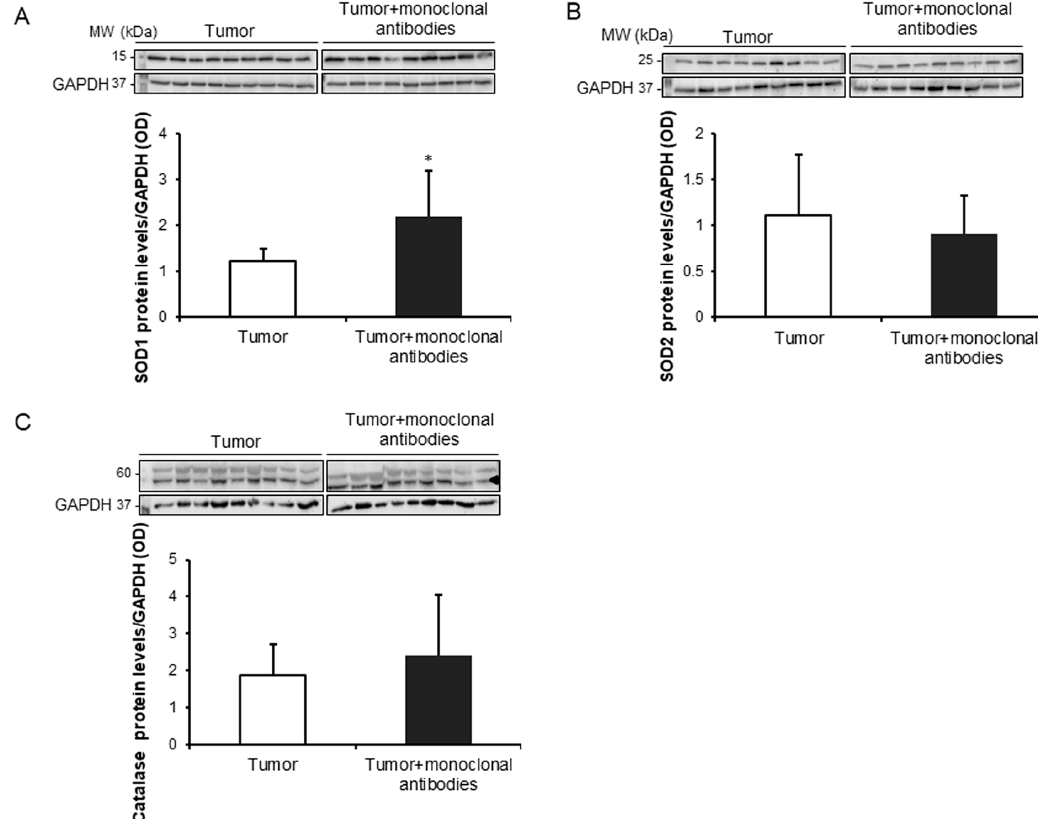
Figure 5. ( A ) Representative immunoblots and mean values and standard deviation of SOD1 protein levels / GAPDH in subcutaneous tumors of lung cancer mice as measured by optical densities. ( B ) Representative immunoblots and mean values and standard deviation of SOD2 protein levels / GAPDH in subcutaneous tumors of lung cancer (LC) mice as measured by optical densities. ( C ) Mean values and standard deviation of catalase protein levels / GAPDH in subcutaneous tumors of lung cancer mice as measured by optical densities. Representative GAPDH is shown as the loading control. Statistical significance is represented as follows: *: p ≤ 0.05 between non-treated controls ( N = 9) in white bars and treated lung cancer ( N = 9) mice in black bars. Definition of abbreviations: SOD1, CuZn-superoxide dismutase; SOD2, Mn-superoxide dismutase; GAPDH, glyceraldehyde-3-phospate dehydrogenase; OD, optical densities.